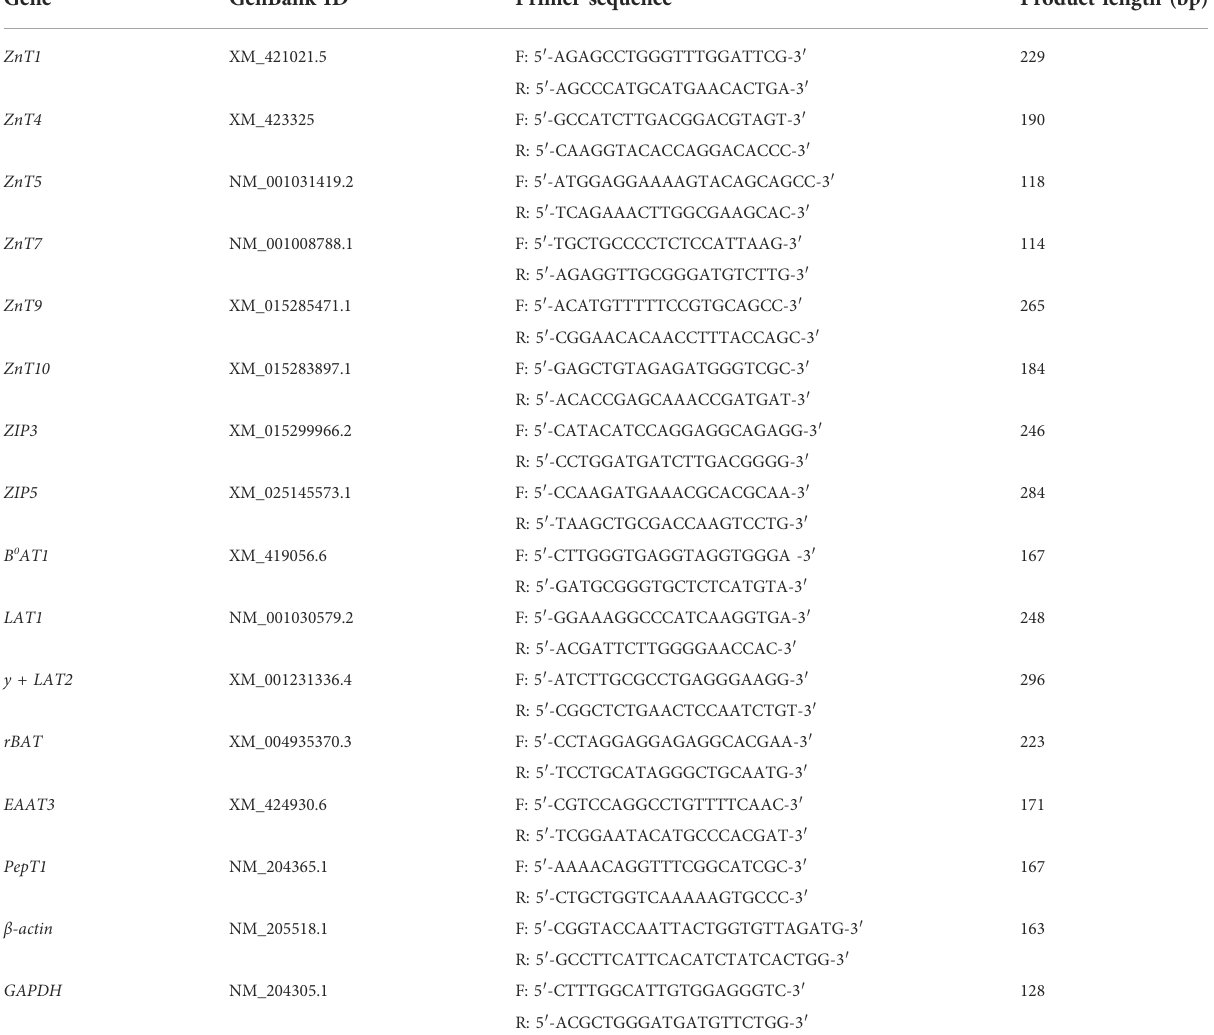
TABLE 3 Primer sequences for real-time PCR ampli fi